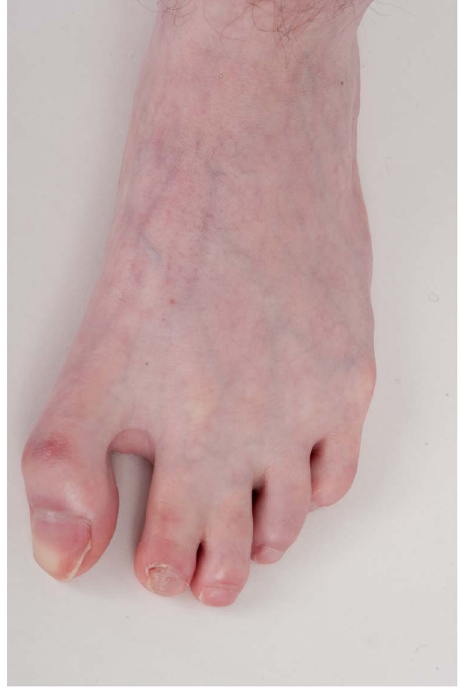
Figure 5. 2–3 cutaneous syndactyly and appearance of cutis marmorata telangiectasia congenita in Patient 3.